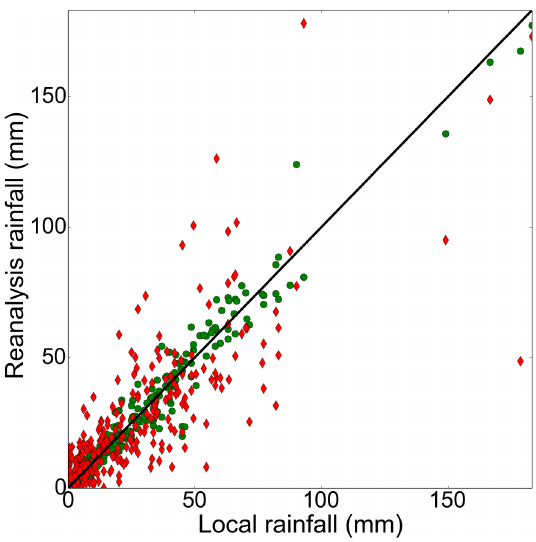
Figure 3. Evaluation of ERA-I/GPCC (red diamond) and SAFRAN (green circle) 10-day cumulative rainfall against local